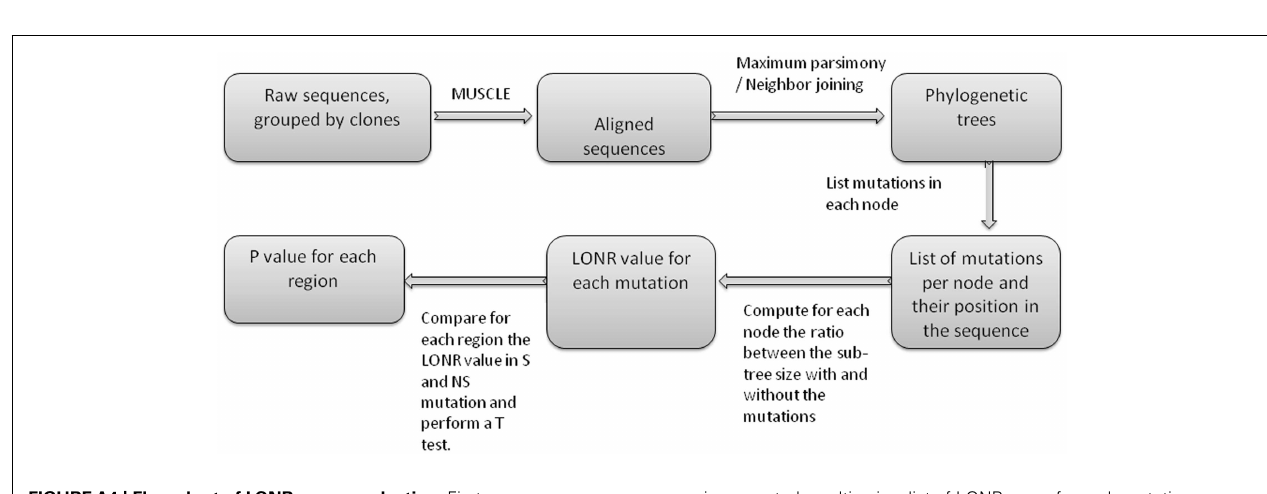
FIGUREA4 | Flow chart of LONR score production . First sequences are aligned, then phylogenetic trees are produced. For each internal node in the trees, a list of mutations is produced (between the internal node and one of its direct descendents). For each such mutation the LONR